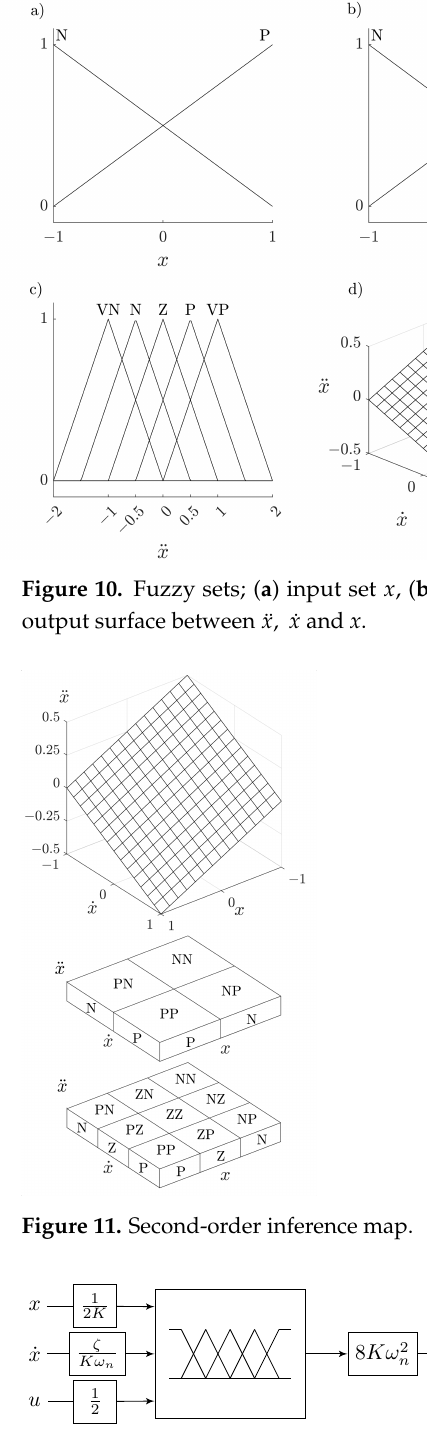
Figure 12. Scaling factors for a second-order